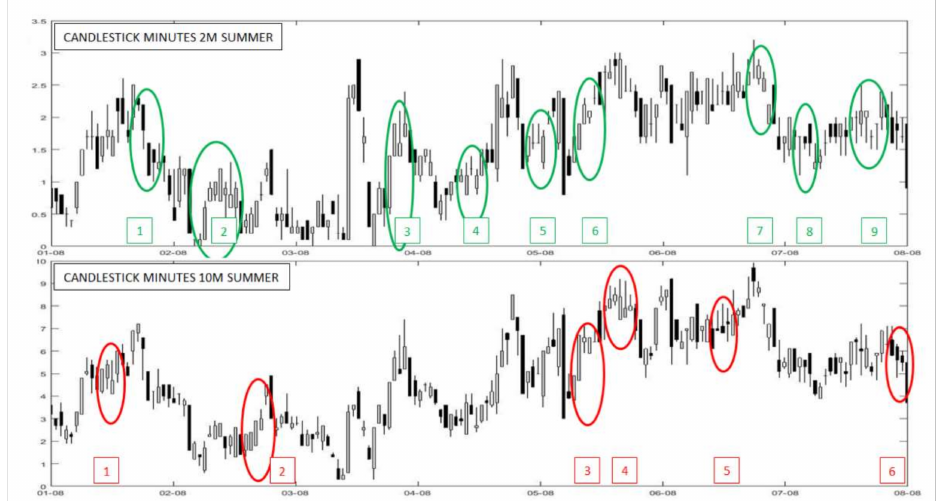
Figure 3. Candlestick chart for Los Montes del Cierzo, hourly resolution, first week of August 2016, at 2 m ( top ) and 10 m ( bottom ) above the